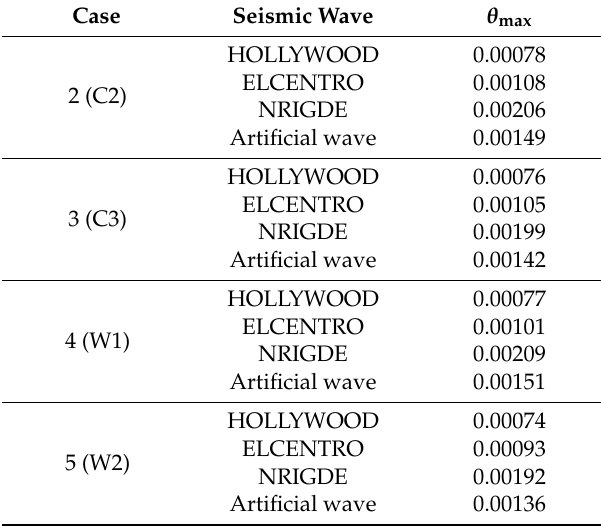
Table 12. The maximum inter-story displacement angle in cases 2, 3, 4 and